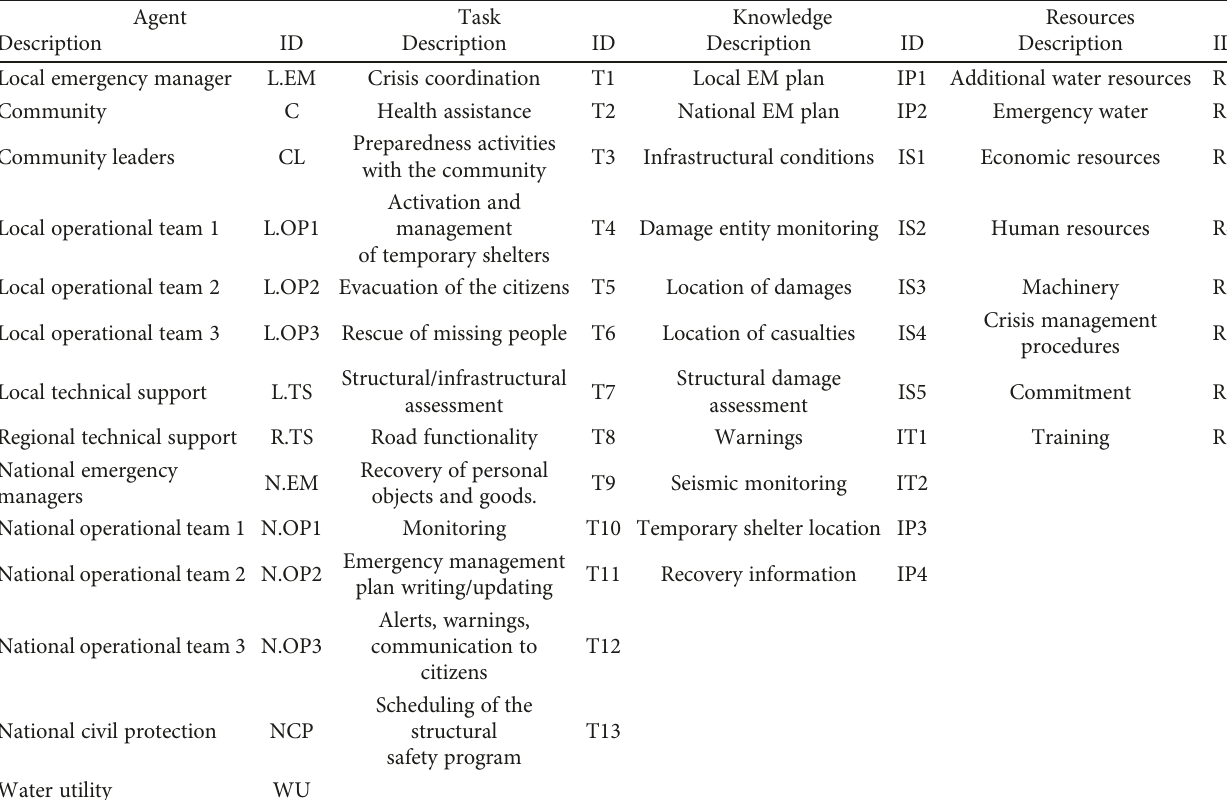
Table 10: List of the agents, tasks, knowledge, and resources suggested by the stakeholders and included in the metamatrix approach.